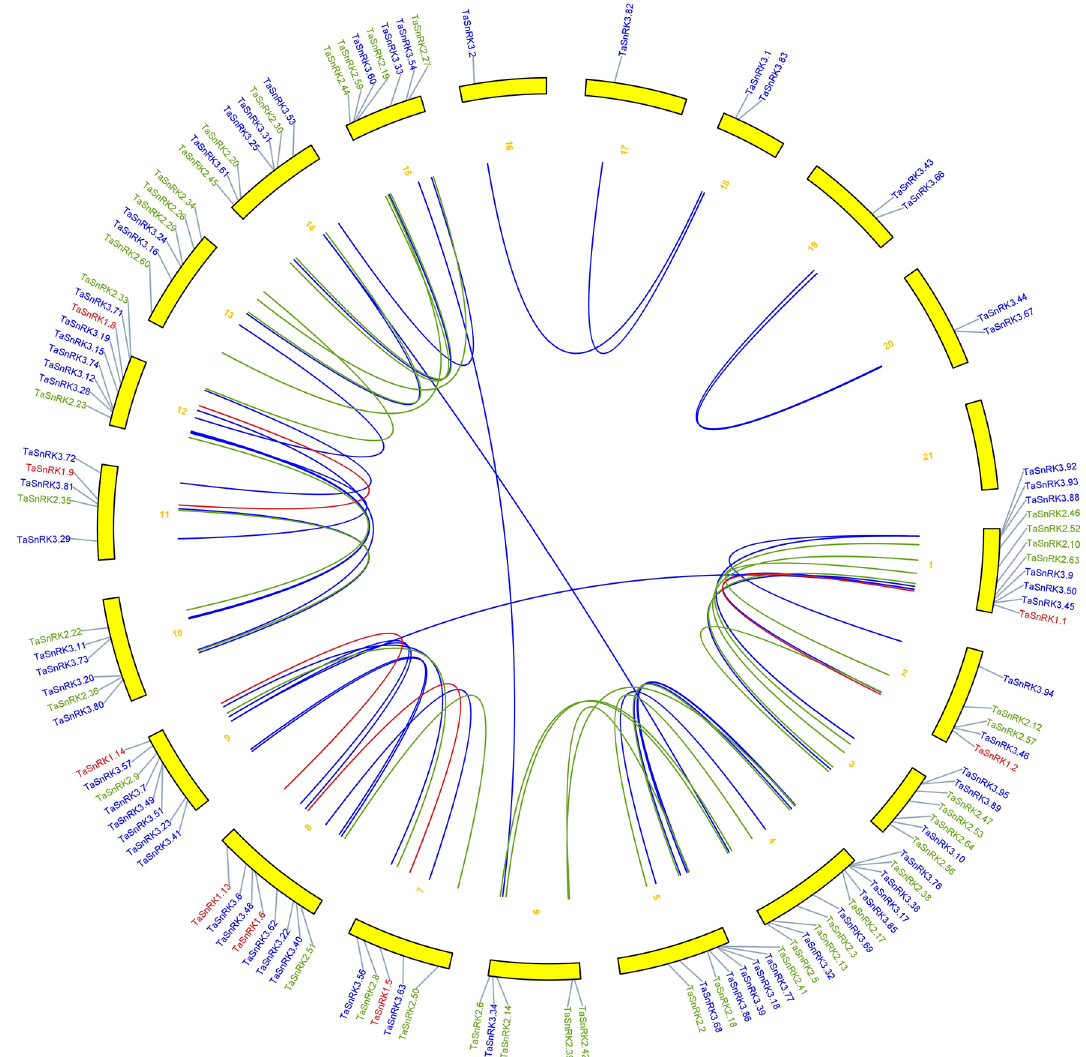
Figure 4. The synteny analysis of TaSnRK family in T. aestivum. Different colours represent SnRK subfamilies red lines indicate duplicated TaSnRK1 subfamily gene pairs, green lines indicated TaSnRK2 subfamily gene pairs and blue represented TaSnRK3 subfamily. The chromosome number is indicated at the bottom of each chromosom.